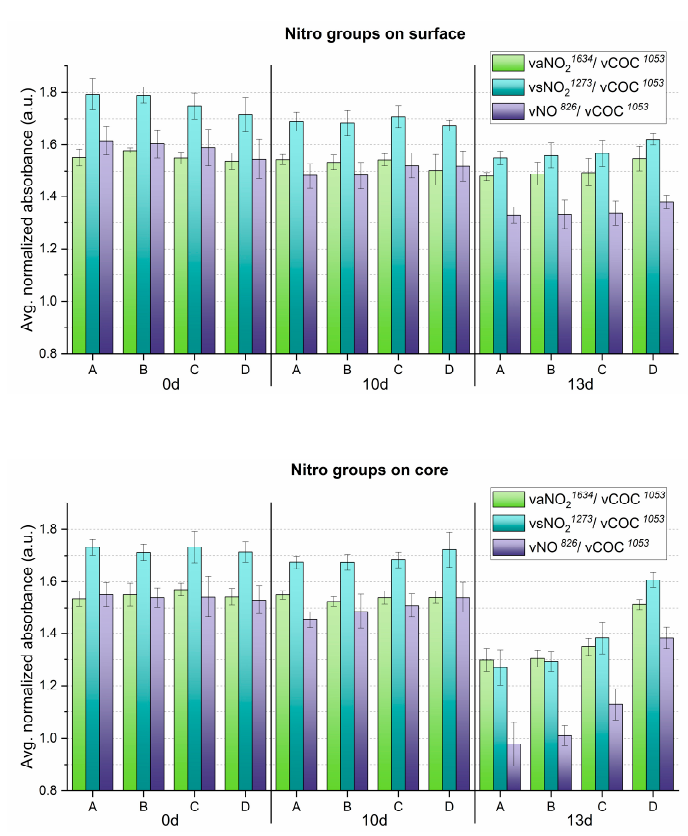
Figure 8. Averaged and normalized ATR-FTIR absorbance for NO 2 groups of the artificially aged celluloid sheets. A, B, C and D refer to sampling points. Error bars correspond to the SD.